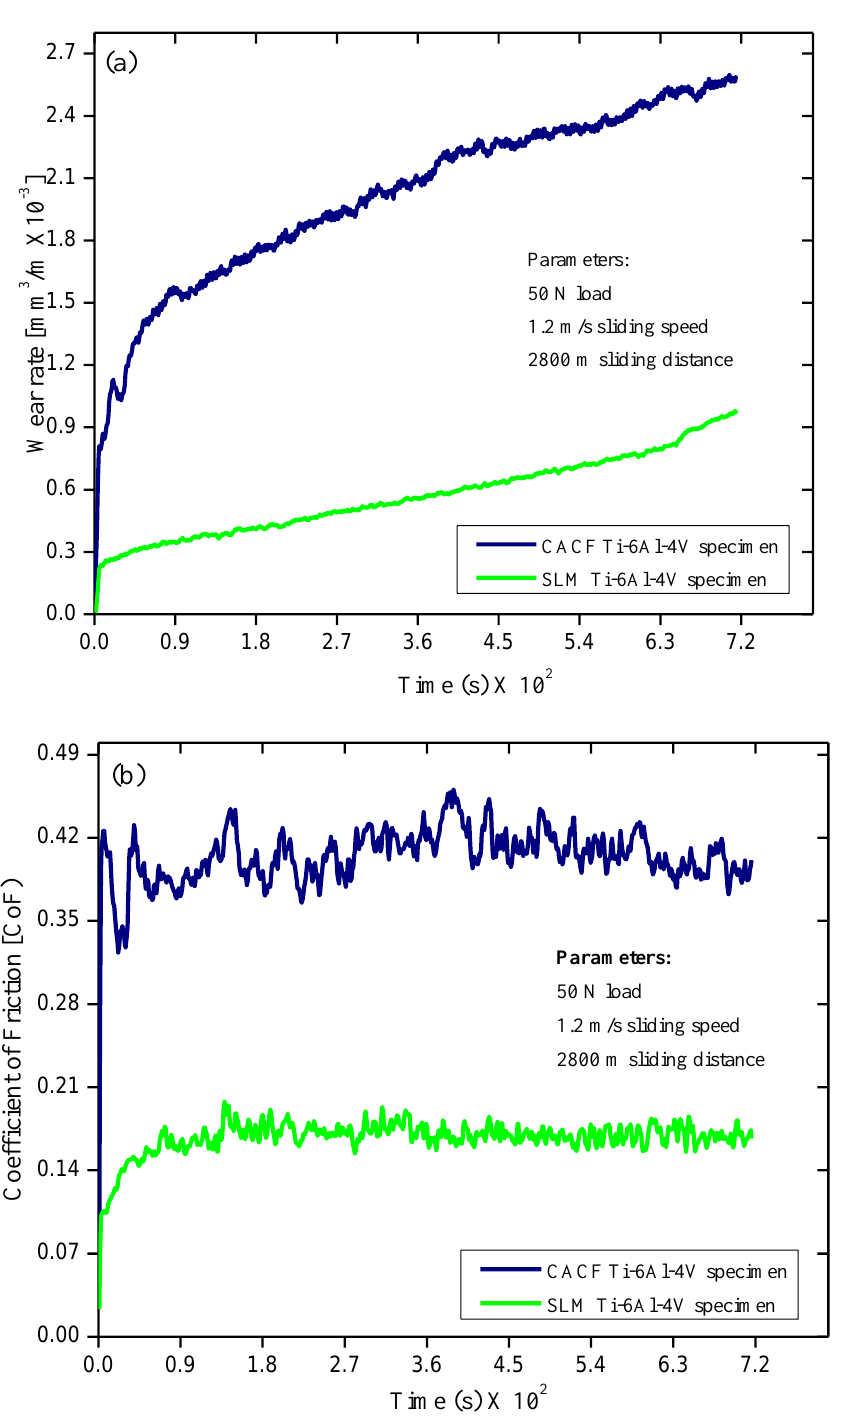
Figure 6. Pin-on-disc wear study results: ( a ) wear rate and ( b ) coefficient of friction Figure 6. Pin - on - disc wear study results: ( a ) wear rate and ( b ) coefficient of friction graph. The COF graph as the function of sliding time for CACF and SLM Ti - 6Al - 4V speci- mens is shown in Figure 6b. The SLM specimen exhibited a lower COF of 0.16, whereas CACF specimens had a higher COF of 0.43 at 50 N load with 1.2 m/s slidings. A higher COF value shows a poor wear behaviour of the material property. In the present study, the CACF specimens exhibited higher COF and poorer wear behaviour than the SLM specimen. The COF was dependent on the variation in the microstructure formation, hardness, and strength of the material [26]. The overall trend of wear rate and COF with